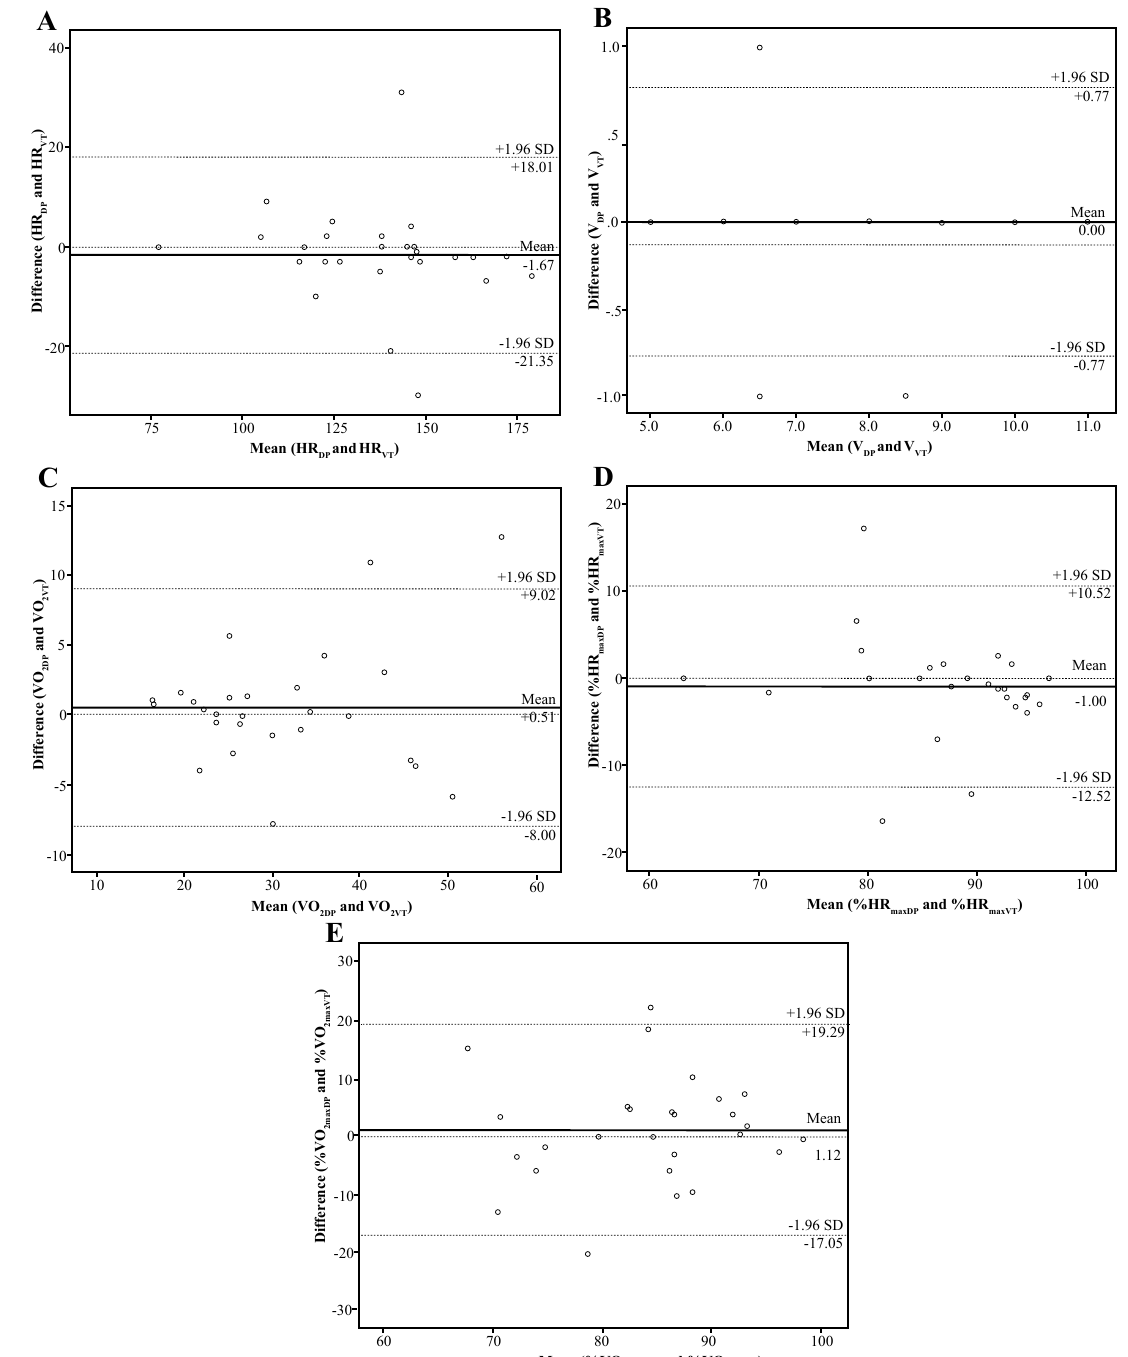
Figure 2. Bland-Altman plots with estimated mean bias and 95% limits of agreement for difference in heart rate (HR) (in bpm) (A), velocity (Km.h -1 ) (B), oxygen uptake (VO2) (in ml.kg -1 .min -1 ) (C), percentage of maximal HR (%HR (in %) (E) corresponding to HRDP and VT, plotted against the